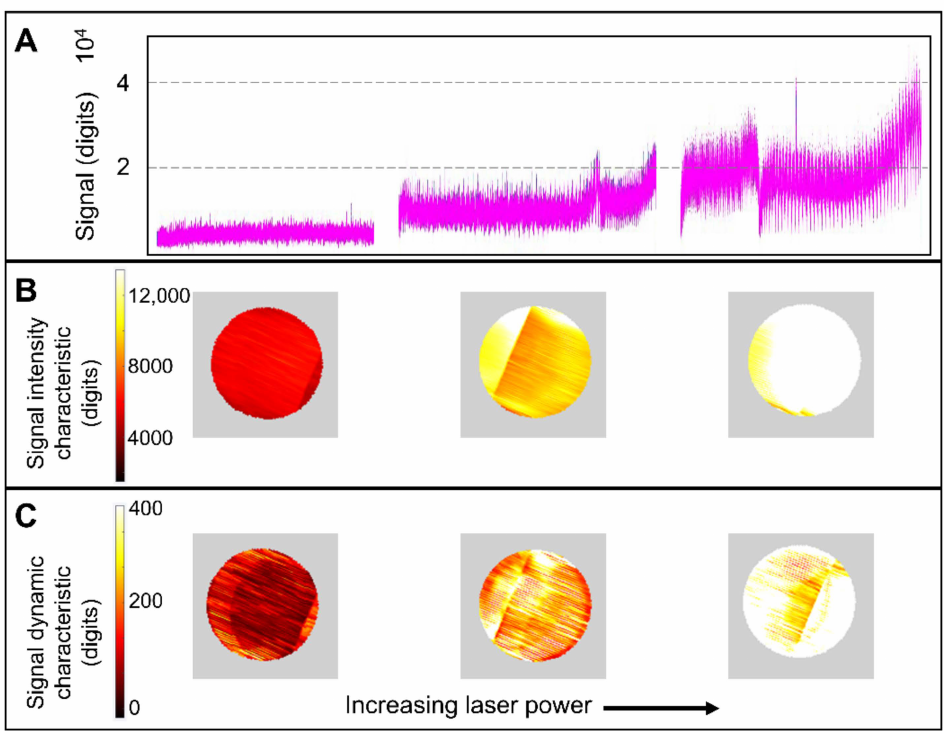
Figure 5. Representative sample of melt pool monitoring in specimens with increasing laser power in the keyhole regime, sampled from the topmost layer of each specimen. Laser power of 100 W, 200 W, and 300 W and otherwise identical parameters (nominal laser scan speed 200 mm/s and layer thickness 40 µ m). ( A ) Raw signal in temporal x-coordinate. ( B ) Signal smoothed and translated to spatial coordinates. ( C ) Signal processed to highlight regions of high melt pool